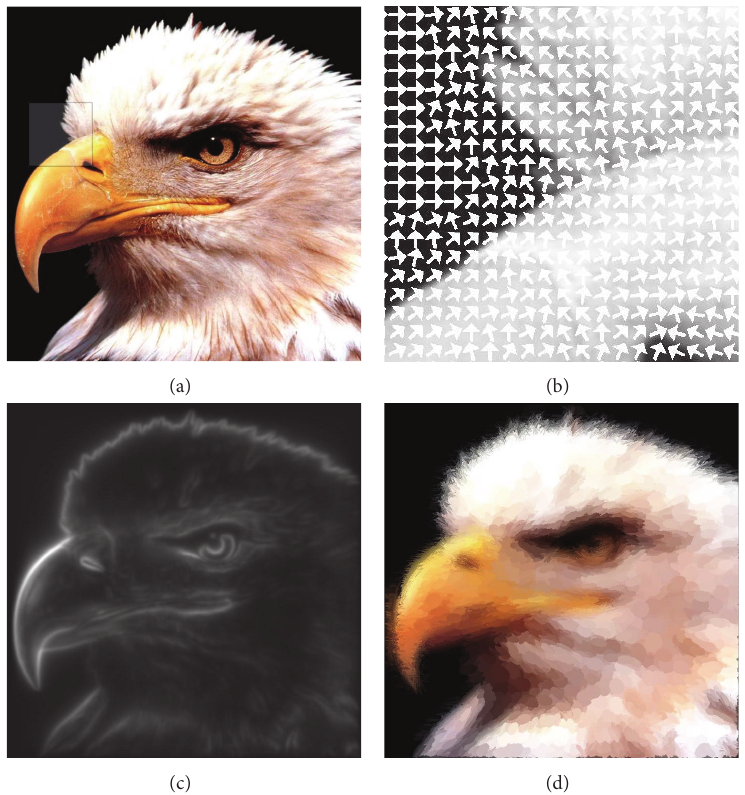
Figure 2: One source image, its direction map, saliency map, and Pointillism ((a), (b), (c), and